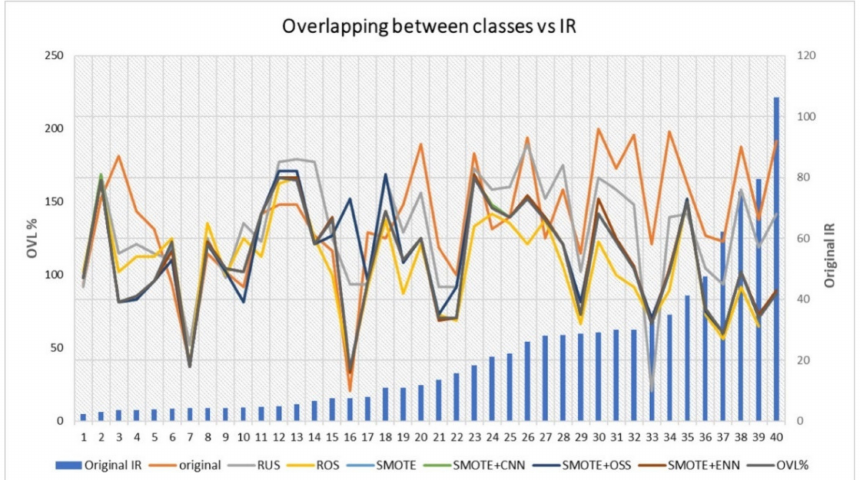
Figure 10. Effect of resampling methods on class overlapping for different values of original